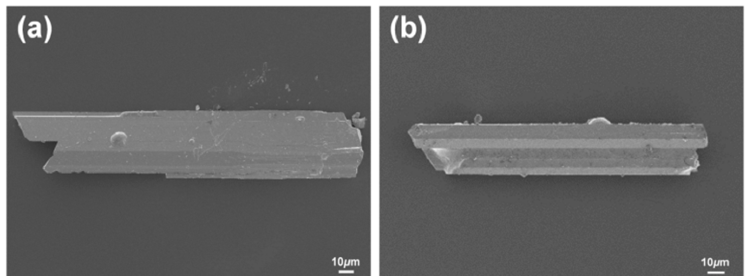
Figure 6. SEM images of needle-shaped single crystals of ( a ) Yb 9.19(3) Ca 4.81 AlSb 11 and ( b ) Yb 8.42(2) Ca 5.58 AlSb 11